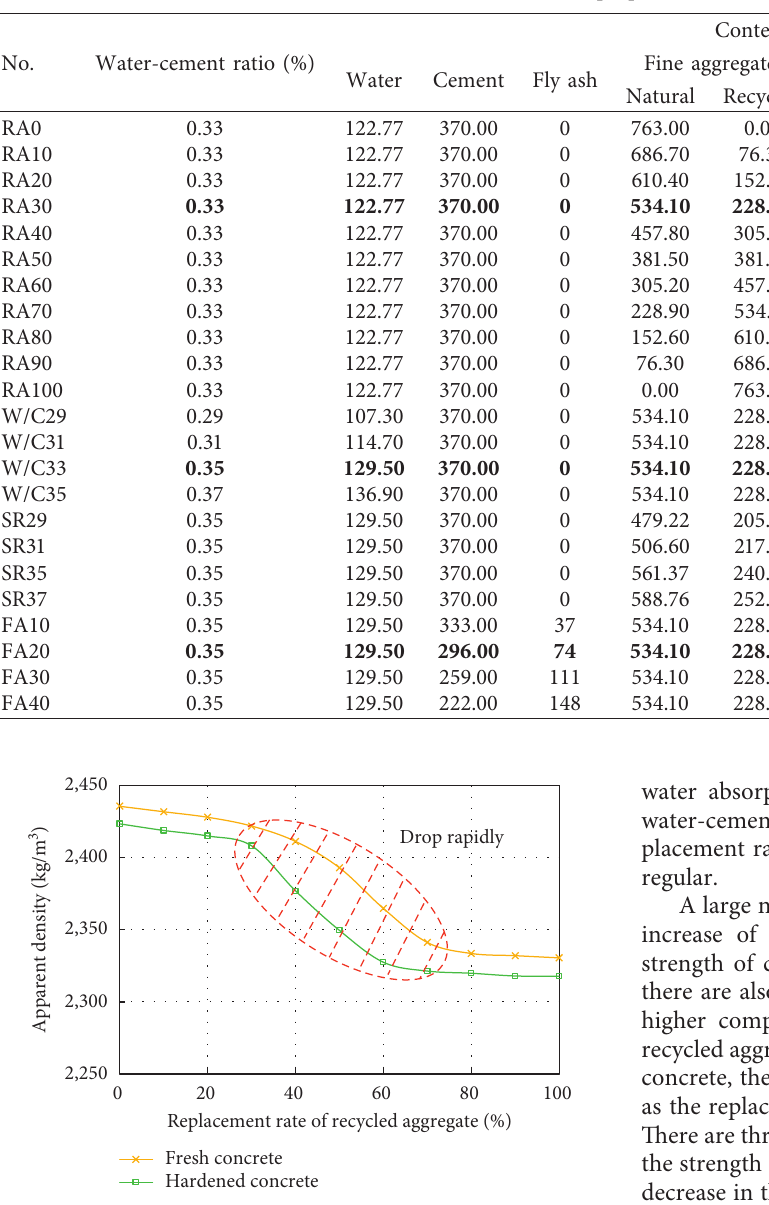
Figure 2: Apparent density of recycled aggregate concrete with different replacement